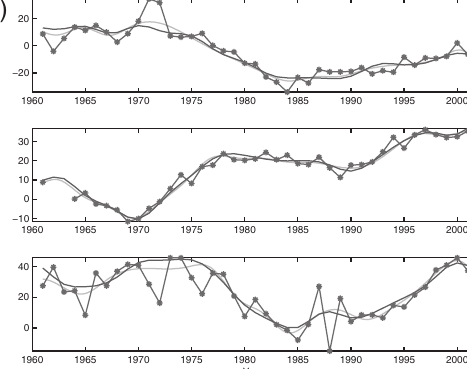
Fig. 6a-c. Time-series for X (first row), Y (second row) and Z (third row) SV components in nTyr –1 , at (a) NGK, (b) TRO and (c) COI locations (see fig. 1 for the locations). The time series are corrected ob- servatory data (thick black), computed values from the EU_MIX model (gray) and CM4 model (black),